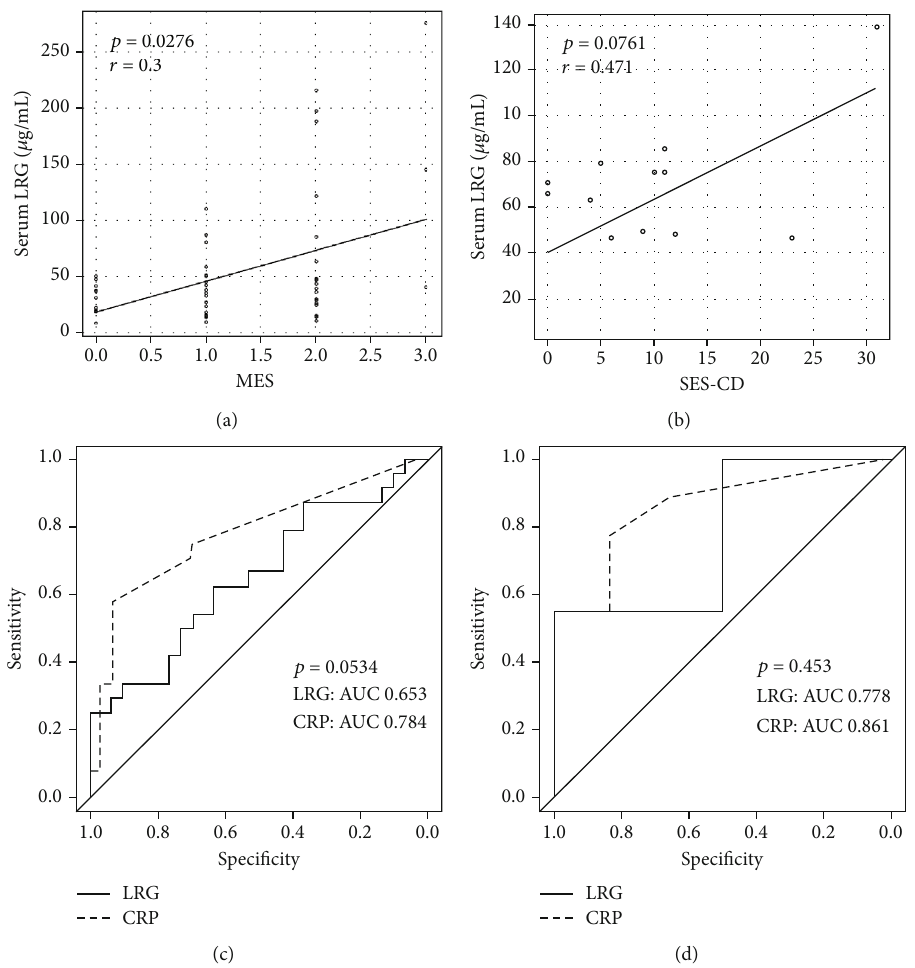
Figure 4: E ffi cacy of the serum leucine-rich alpha-2 glycoprotein (LRG) level as a biomarker for ulcerative colitis assessed using the Mayo endoscopic subscore (MES) (a) and for Crohn ’ s disease assessed using the simple endoscopic score for Crohn ’ s disease (SES-CD) (b). Receiver operating characteristic (ROC) curves for serum LRG and C-reactive protein (CRP) levels, as evaluated using the MES in ulcerative colitis (c) and the SES-CD in Crohn ’ s disease (d). Values of the area under the ROC curve (AUC) are shown. Endoscopic remission was de fi ned as MES ≤ 1 in UC and SES ‐ CD ≤ 4 in